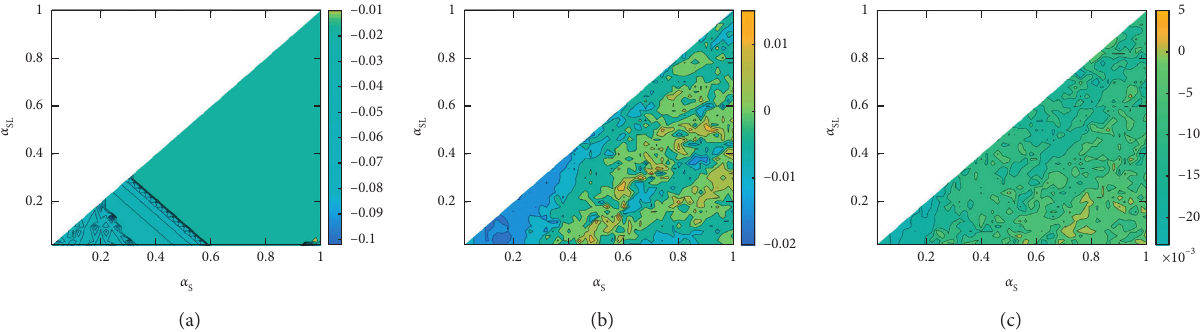
Figure 9: LLE diagram of supply chain nodes under the scenario of random demand obeying normal distribution from the global � 5. (a) The retailer’s LLE chart. (b) The LLE chart of the distribution center. (c) The LLE chart of the perspective when G d � 2 and G 2 combined system from the decision perspective.